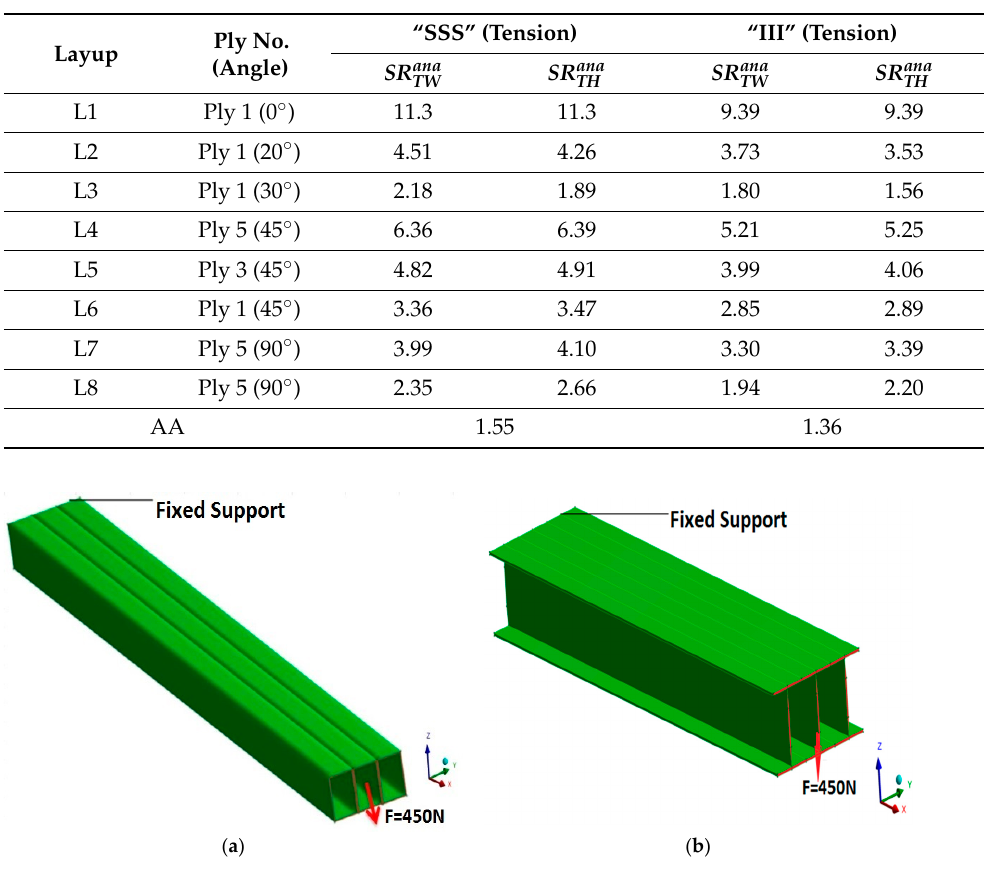
Figure 6. Proposed multi ‐ cell beams subjected to bending loads: ( a ) “SSS” beam under the bending moment, and ( b ) “III” beam under the bending moment.